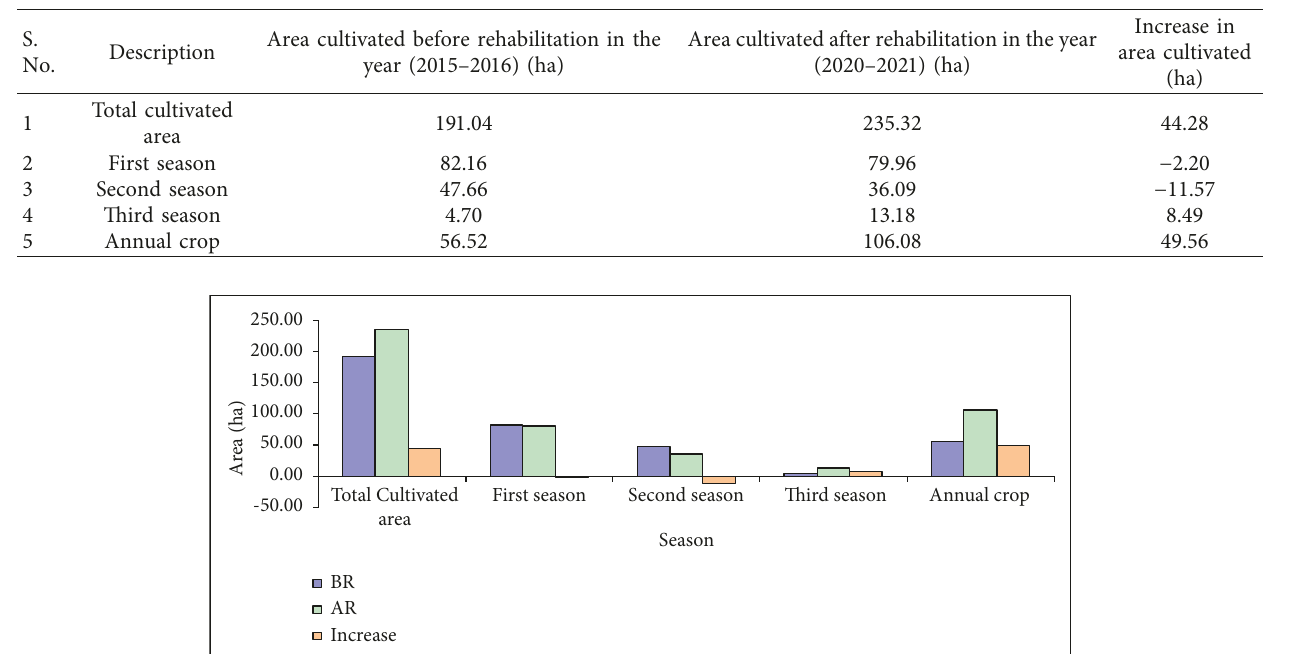
Table 4: Season-wise total area cultivated before and after rehabilitation.